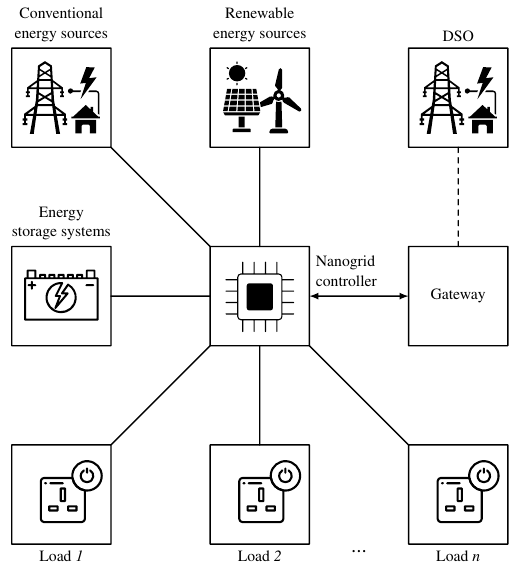
Figure 1. Typical structure of a nanogrid distribution